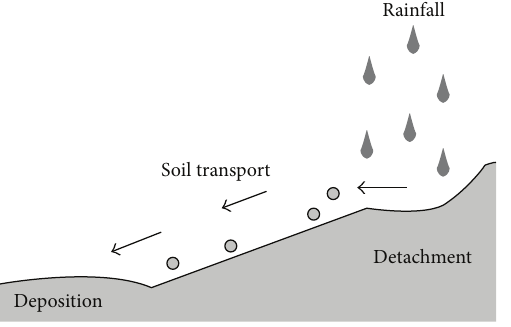
Figure 1: Mechanism of soil erosion.